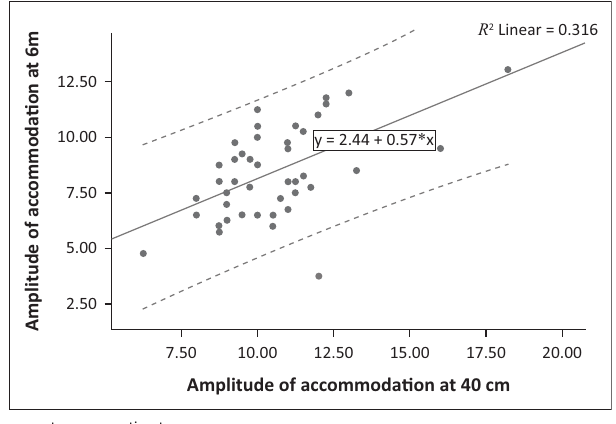
FIGURE 2: Linear regression of the amplitude of accommodation measured with the target at 40 cm against the amplitude of accommodation measured with the target at 6 m ( r = 0.56, p = 0.00).